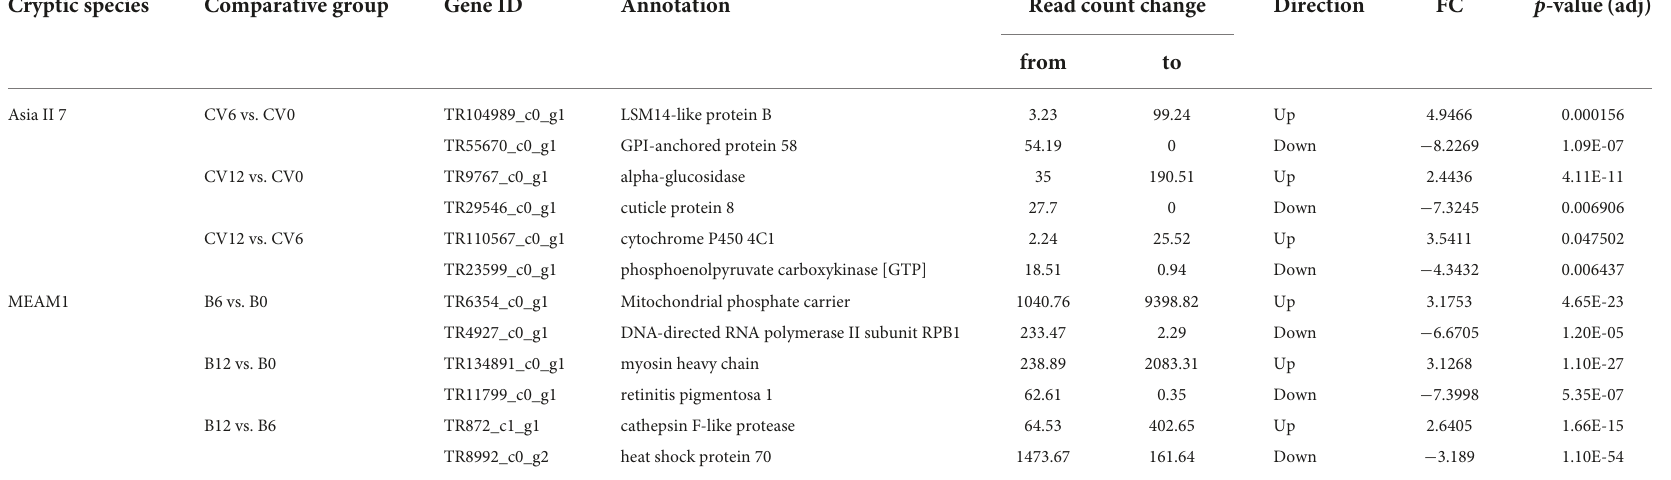
TABLE 4 Important CLCuMuV-regulated candidate DEGs in Asia II 7 and MEAM1